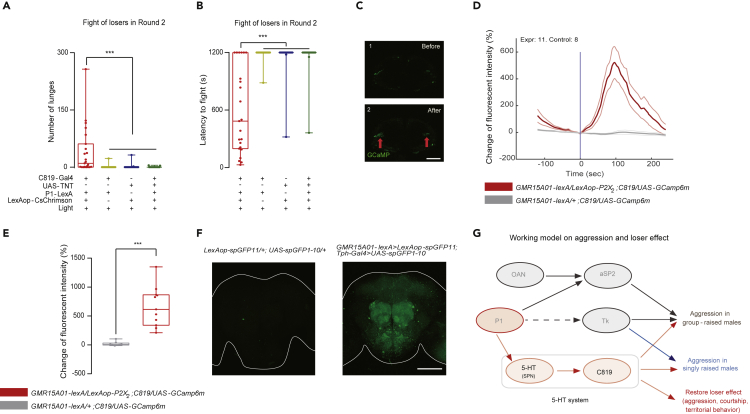
P1 Neurons Act Upstream of 5-HT Signaling(A and B) Activating P1 neurons (labeled by R15A01-LexA) while simultaneously silencing C819 neurons did not induce aggression in losers, reflected by the low fighting intensity (A) and long latency to fight (B) (n = 23).(C–E) Visualization of functional connectivity between P1 and C819 neurons by applying ATP directly to the brain. P1 neurons responded to ATP and resulted in increased GCaMP signals in C819 neurons. Genotypes are indicated at the bottom. (C) Images of confocal sections of GCaMP signals in the C819 neurons: before ATP delivery (C1) and after ATP delivery (C2). (D) Traces of fluorescent intensities of C819 neurons before and after P1 activation. Time zero is indicated by a blue line. Red lines label the signals from the experimental group, and gray lines label the control group. Thick lines represent the average signals, and thin lines indicate one standard deviation (n = 8–11). (E) Maximal changes of fluorescent intensity in C819 neurons after P1 activation (n = 8–11).(F) GRASP signals revealed structural connections between P1 neurons and 5-HT neurons. Left: an image of the brain of control flies with spGFPs only. Right: R15A01-LexA drove the presynaptic component (spGFP11), and Tph-Gal4 drove the postsynaptic component (spGFP1–10).(G) Working model of the 5-HT system on controlling aggression and loser mentality at the circuit level. Besides arousing or increasing aggression across flies with different social experiences, the 5-HT system also regulates the aggression restore in losers, with P1 neurons acting upstream. The Kruskal-Wallis test was performed for (A) and (B); the t test was performed for (E). ∗∗∗P < 0.001. Scale bar, 100 μm.